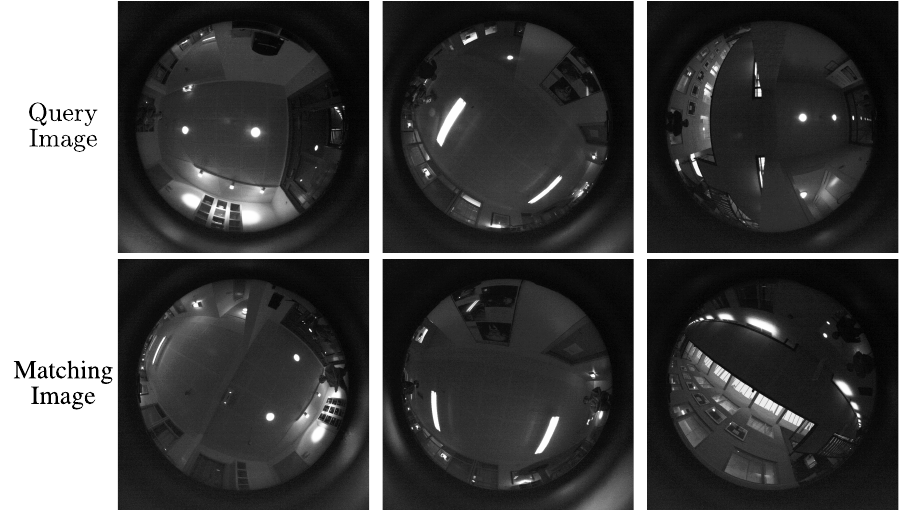
Figure 12. Examples of correct place recognition where the robot location is rotated significantly between test and training images. The left image of each row shows the query test image, and the right image show the correctly matched image from the training